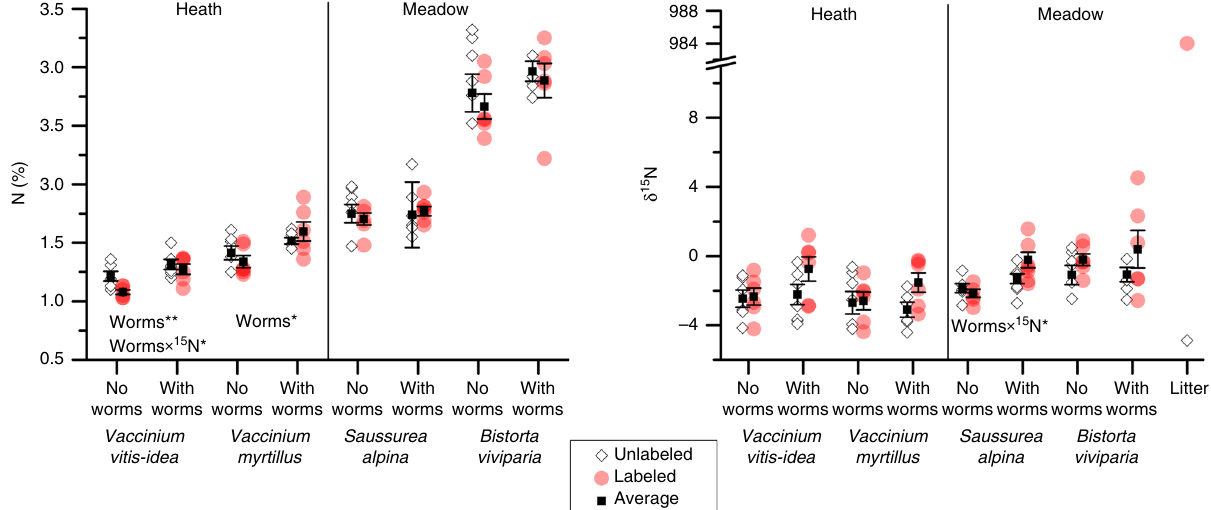
Fig. 3 Earthworm effects on nitrogen uptake of common heath and meadow species. Nitrogen content and δ 15 N signatures of dwarf shrubs found only in heath ( V. vitis-idea and V. myrtillus ) and forbs found only in meadow ( S. alpina and B. viviparia ) in response to geoengineering earthworms. Note that these plant species were only found in one of the two vegetation types and thus did not allow comparison of effects between vegetation types. Individual replicates of samples from unlabeled (white diamond shape) and δ 15 N labeled (red circle, where darker values indicate overlapping data) mesocosms are shown with average values (black square, ±std. err). Main effects and interaction effects are presented as text for each panel (effect of the labeled litter is indicated using the 15 N symbol) along with symbols indicating signi fi cance level ( P < 0.05 are shown using *, and signi fi cance levels <0.001 are indicated as ***). Note the cut off in the y -axis to show the δ 15 N signatures of the unlabeled and the labeled litter. Source data are provided as a Source Data fi le. Table 1 Effects of geoengineering earthworms on litter cover and microbial and plant communities. Litter cover (%) Actinomycetes Bacteria Fungi (nmol/g soil) (nmol/g soil) (nmol/g soil)